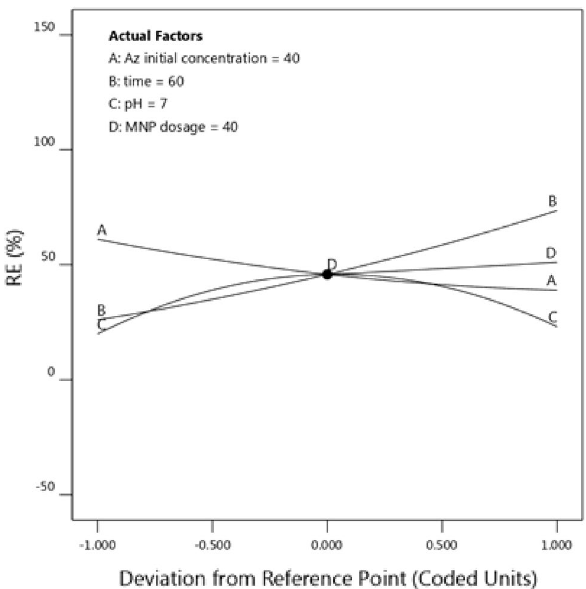
Figure 7. Perturbation curve for removal efficiency versus coded parameters.